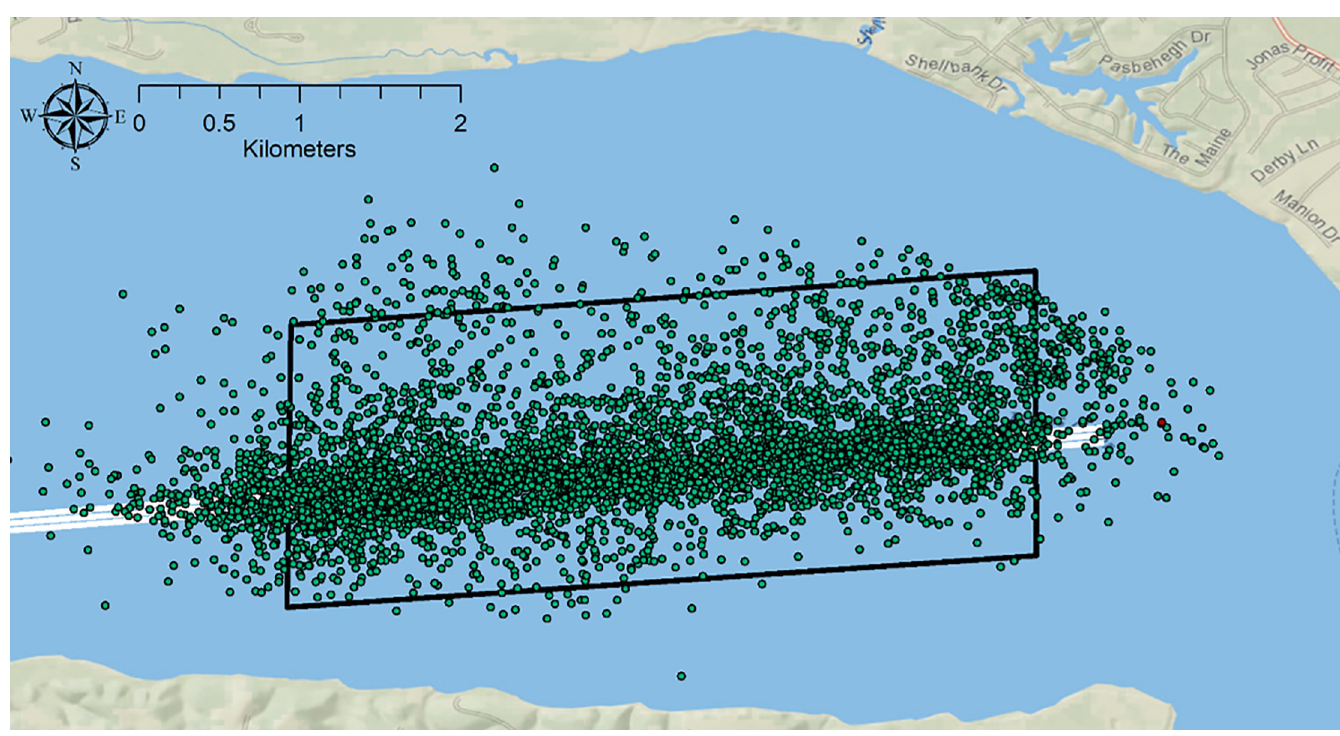
Fig 4. Points showing all adult Atlantic sturgeon positions generated by the Vemco Position System array. The black box is the extent of the Getis Gi � Hotspot analysis. In total 99 adults were represented and 5839 positions were recorded, of which 5,011 were used after the points were vetted for accuracy. Basemap reprinted from Ocean Basemap under a CC BY license, with permission from ESRI, original copyright